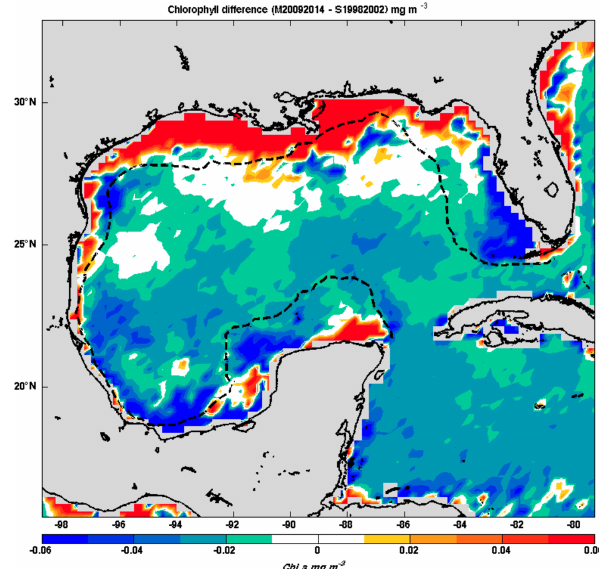
Figure 10. Differences in Chl a concentration (mgm − 3 ) for 2009– 2014 average values of MODIS data minus 1998–2002 average Sea- WIFS values. The broken line represents the 250m isobath. White contoured areas indicate no significant